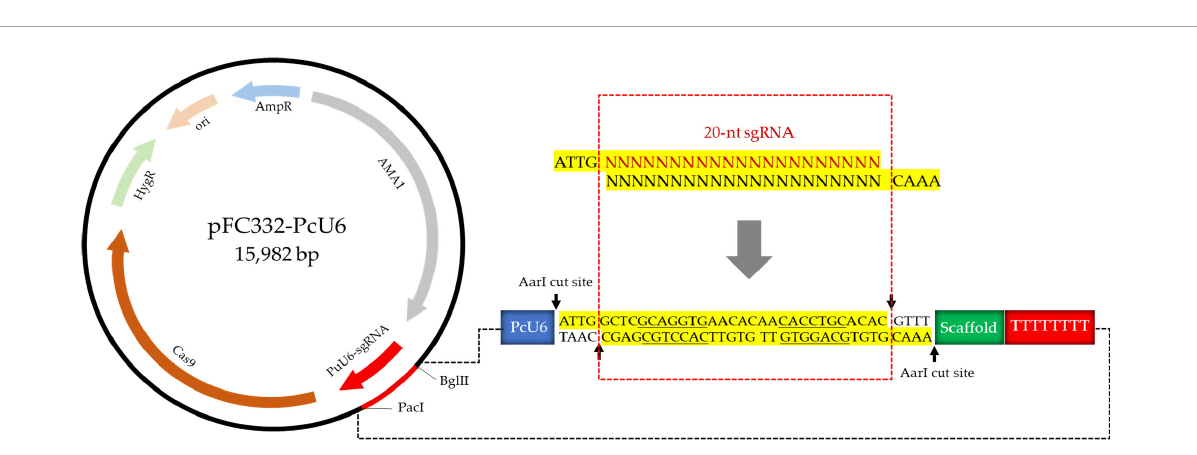
FIGURE2 The schematic of construction of pFC332-PcU6 plasmid including the endogenous U6 promoter, sgRNA site containing Aar I restriction sites, the sgRNA scaffold sequence, and the terminator.